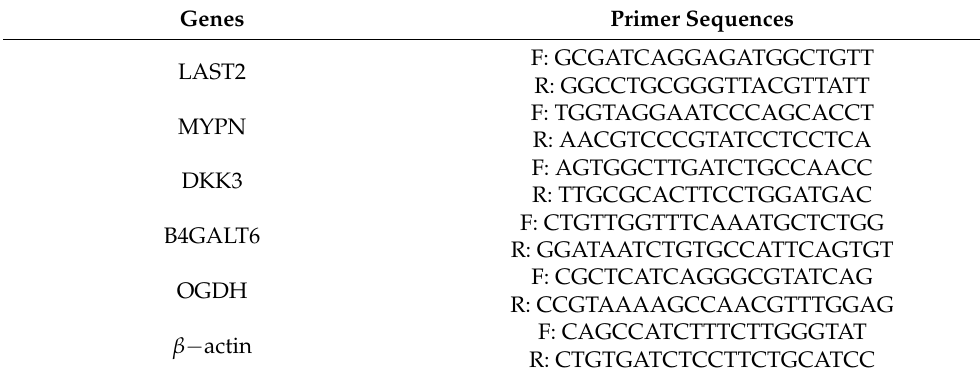
Table 1. Primers for RT −